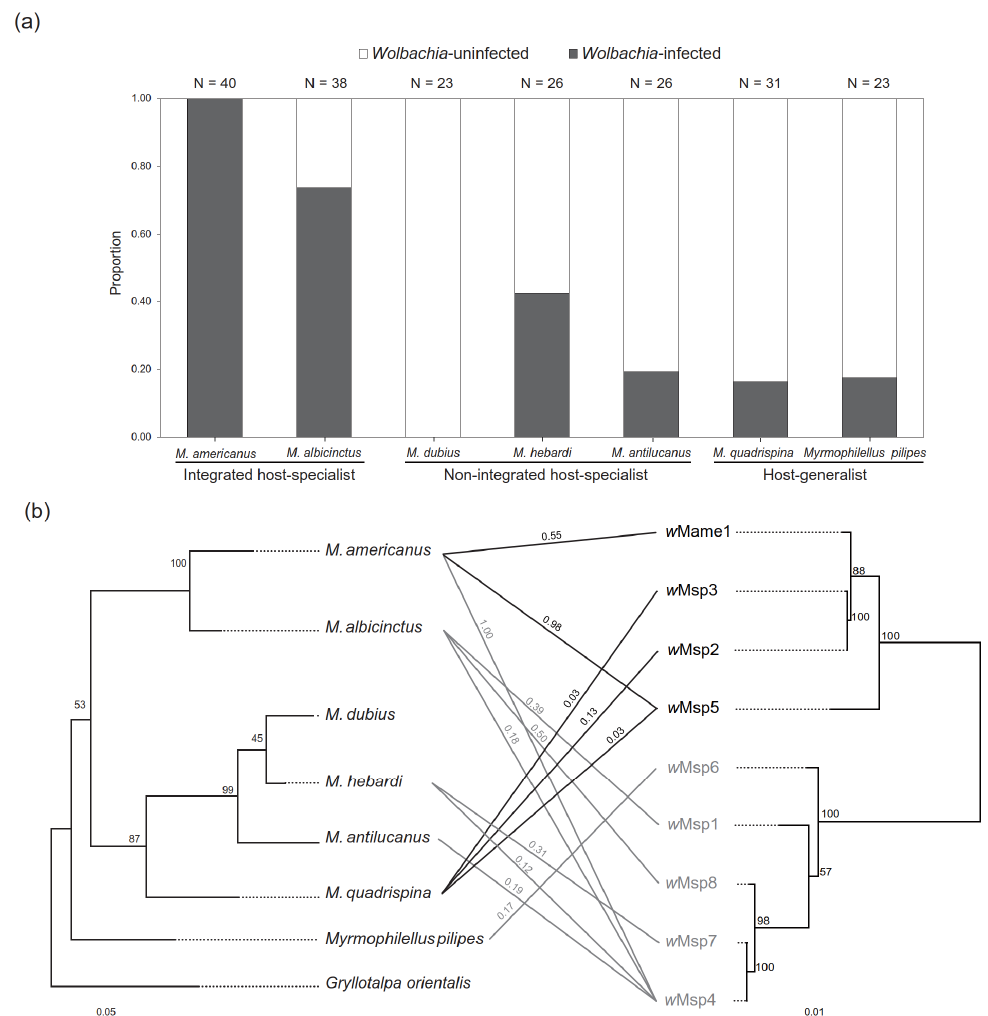
Figure 1. ( a ) Wolbachia infection rates of ant crickets; ( b ) Maximum Likelihood (ML) phylogeny of ant crickets (left) and their corresponding Wolbachia strains (right) based on cytb sequences and concatenated sequences of wsp and MLST, respectively. Numbers at nodes indicate bootstrap support values (100 replicates). Ant cricket- Wolbachia associations are indicated by lines (black: supergroup A; gray: supergroup F), and the number above the line indicates the infection rate of each Wolbachia strain. Wolbachia strain w Mame2 was excluded from the phylogenetic analysis due to the lack of reliable MLST data.